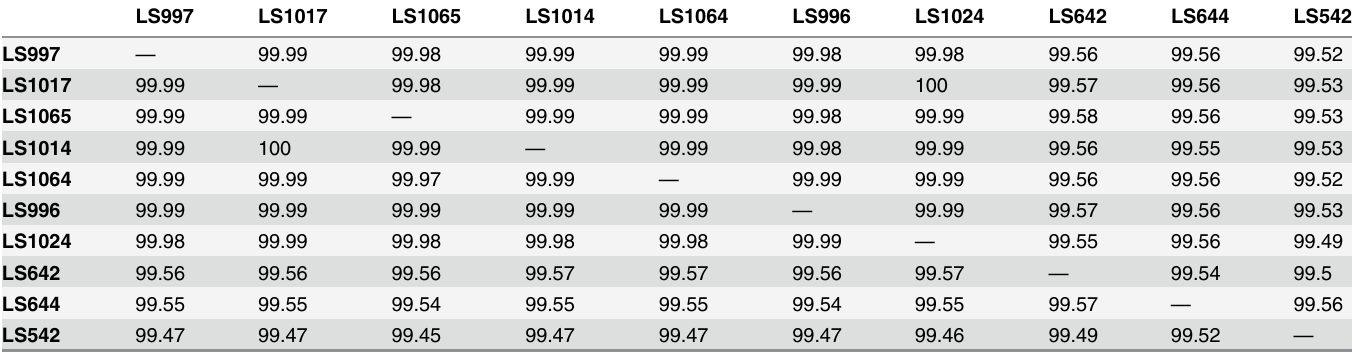
Table 4. JSpecies ANIb of a subset of the 4bV Strains again shows a higher level of relatedness between the apple and stone fruit linked isolates and 4bV strains from unrelated